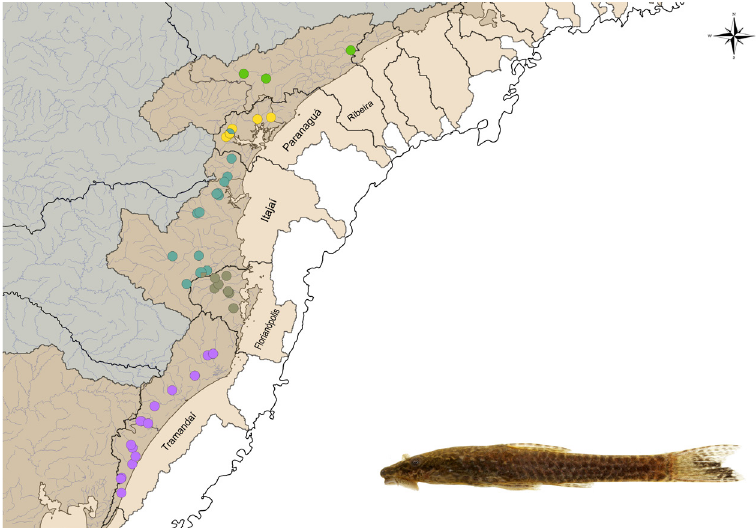
FIGURE 1 | Map of geographic distribution and included samples of Hisonotus leucofrenatus from coastal drainages of southeastern Brazil. Colors of the circles represent groups sampled according limits of paleodrainage systems for the region and sample photo of Hisonotus leucofrenatus from Tramandaí River system, UFRGS 16528 (photo by L. R. Malabarba).